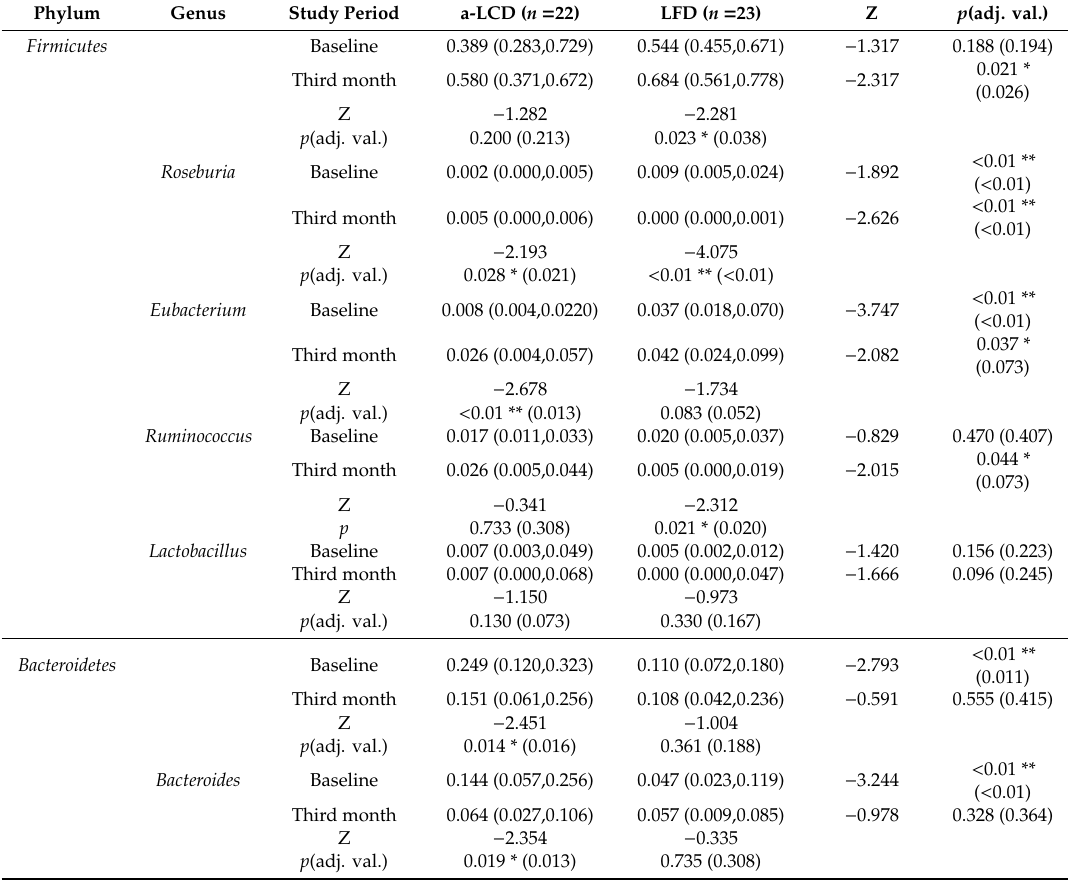
Table 8. Comparison of the composition of gut microbiota [M(P25,P75)] in the two groups.